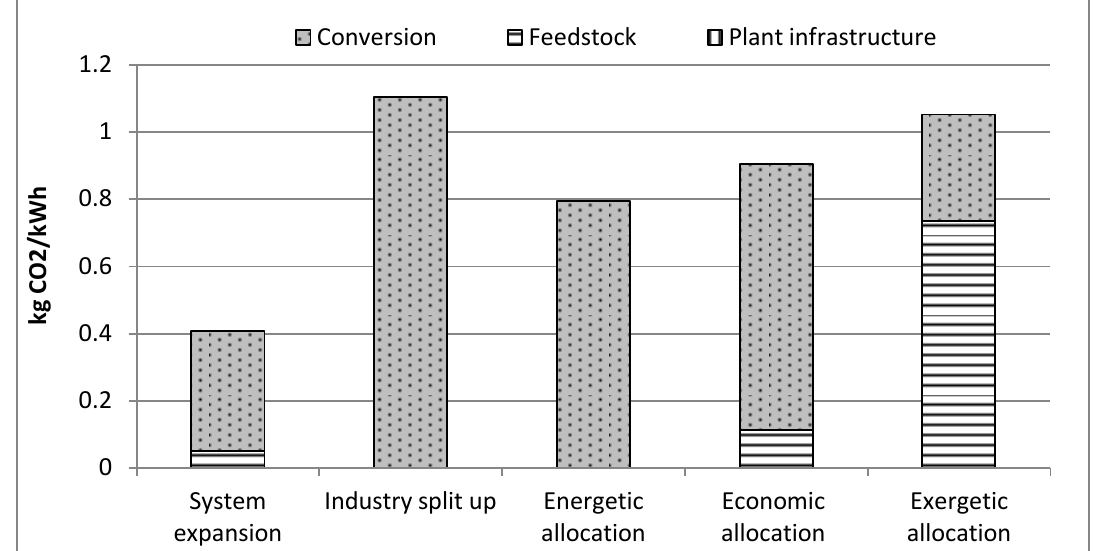
Figure 5. Average impact on climate change for the production of 1 kWh with blast furnace gas with the different allocation